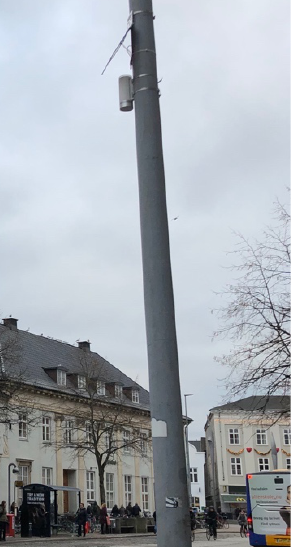
Figure 4. Station 16 in the sensor network mounted with a MONTEM CityProbe. The height of the CityProbe should be at least 4